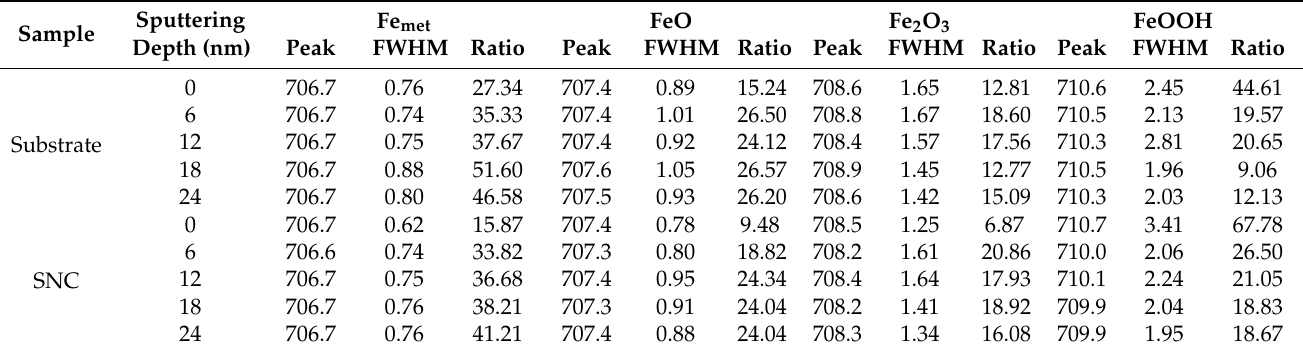
Table 5. Fe 2p 3/2 spectral fitting parameters: binding energy (eV), FWHM value (eV), and area ratio